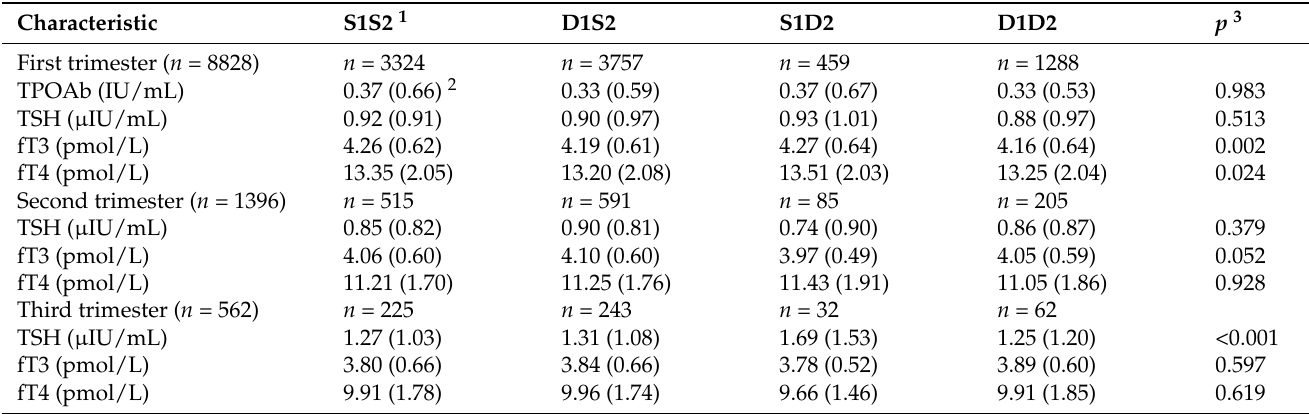
Table 2. Parameters of thyroid function with different VitD status in three